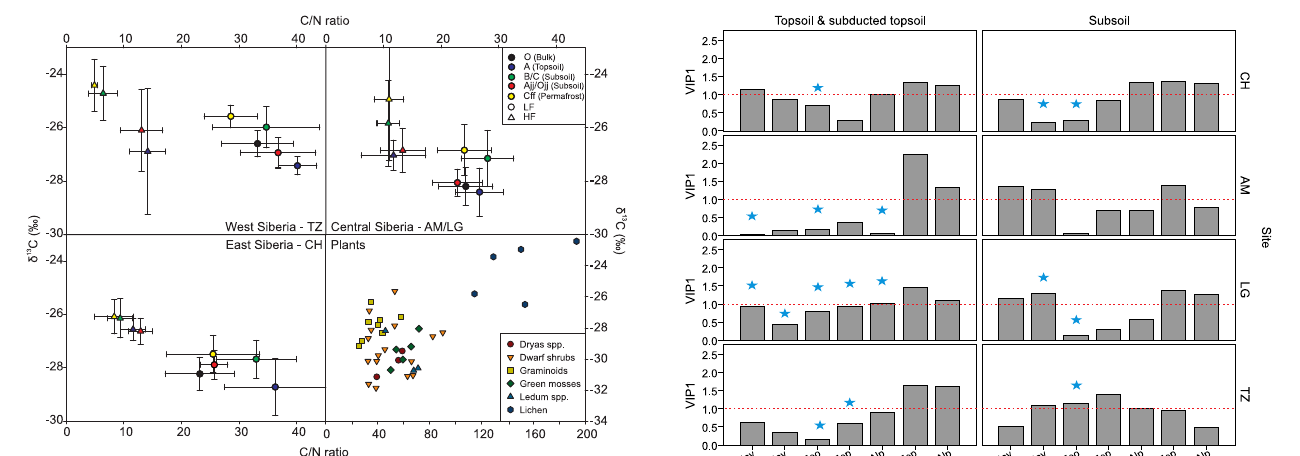
Figure 6. δ 13 C vs. C / N ratios for individual soil fractions and the most abundant plants. The values of the soil fractions were grouped according to the genetic soil horizons (mean value ± SD) and plot- ted for the different sampling sites. The central Siberian plot incor- porated the two sampling sites, AM and LG, where no significant differences were observed for the evaluated parameters. Note the different scale of the plot in the lower right corner.